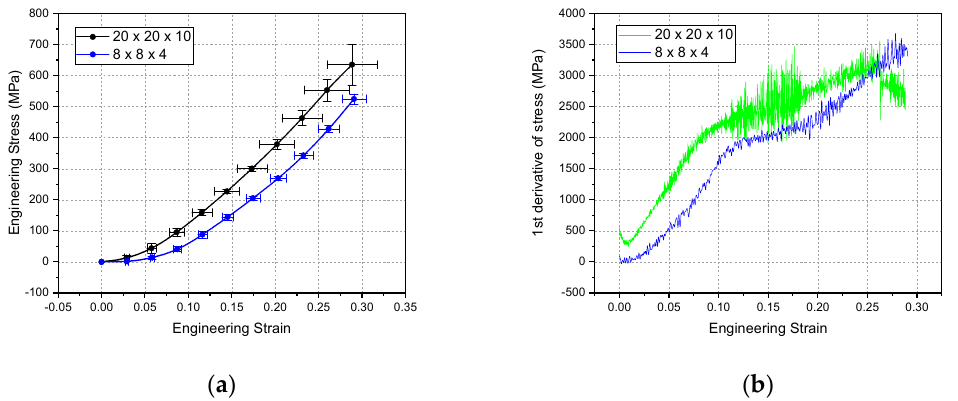
Figure 4. The quasi-static compressive behavior under out-of-plane loading: ( a ) stress–strain curve; ( b ) first derivative of stress vs. strain curve.